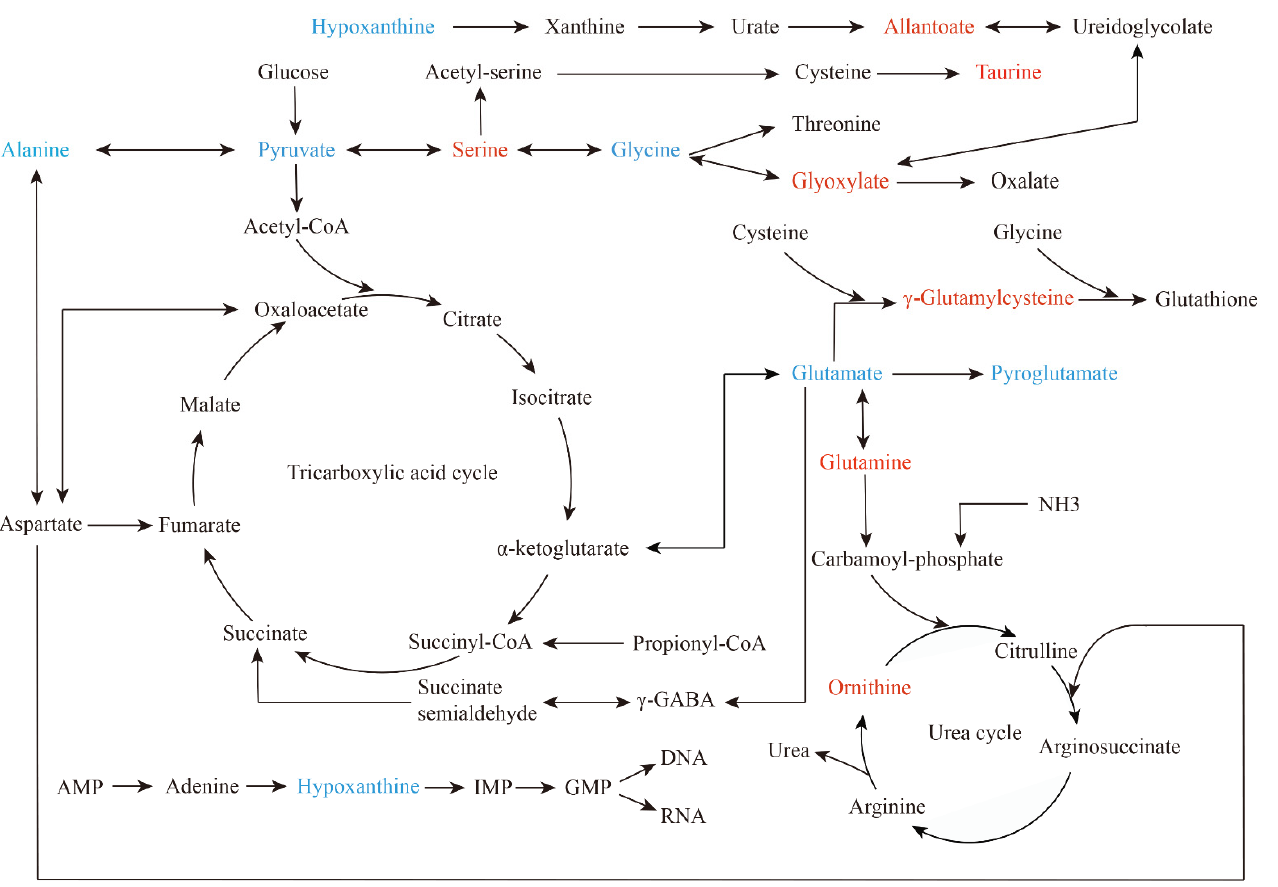
Figure 6. Summary of significant metabolic pathways about sensitivity to NAC in bladder cancer. It is mapped according to KEGG pathway (https://www.genome.jp/kegg/pathway.html (accessed on 11 April 2022)). Red represents elevated metabolites in the sensitive group, and blue represents reduced metabolites.